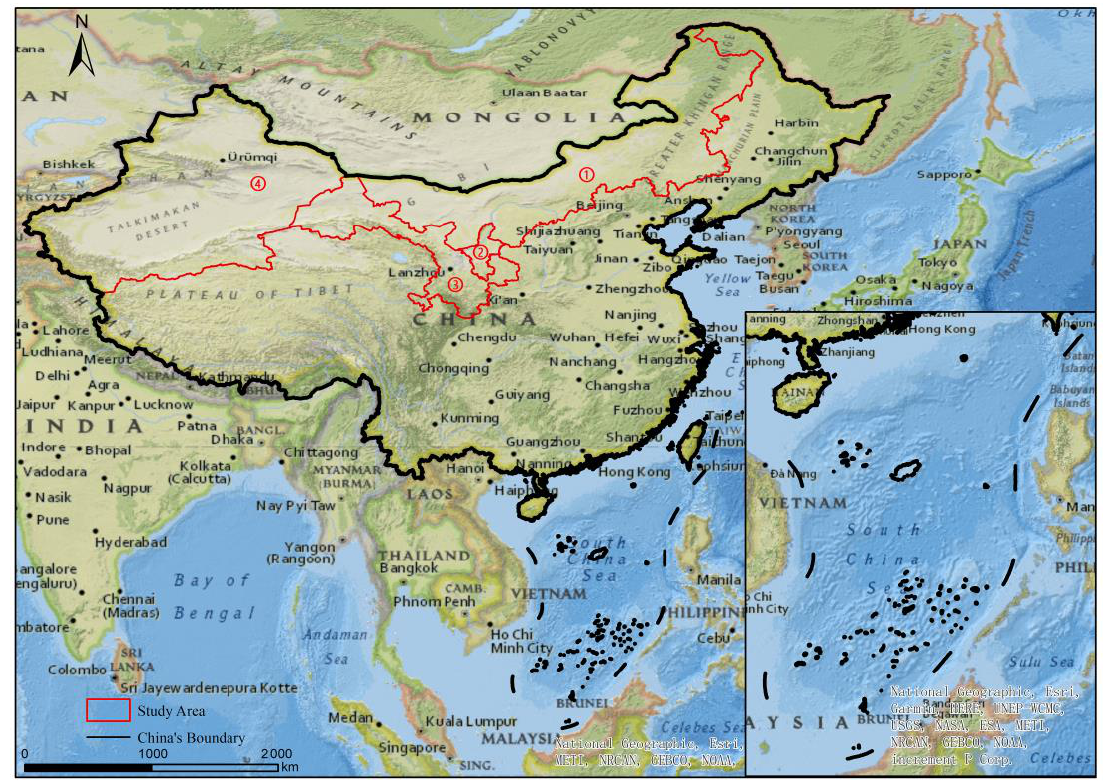
Figure 1. Study area: four provinces in northern China. 1 — Inner Mongolia. 2 — Ningxia. 3 — Gansu. 4 — Xinjiang. The four provinces include most of the grassland in northern China.